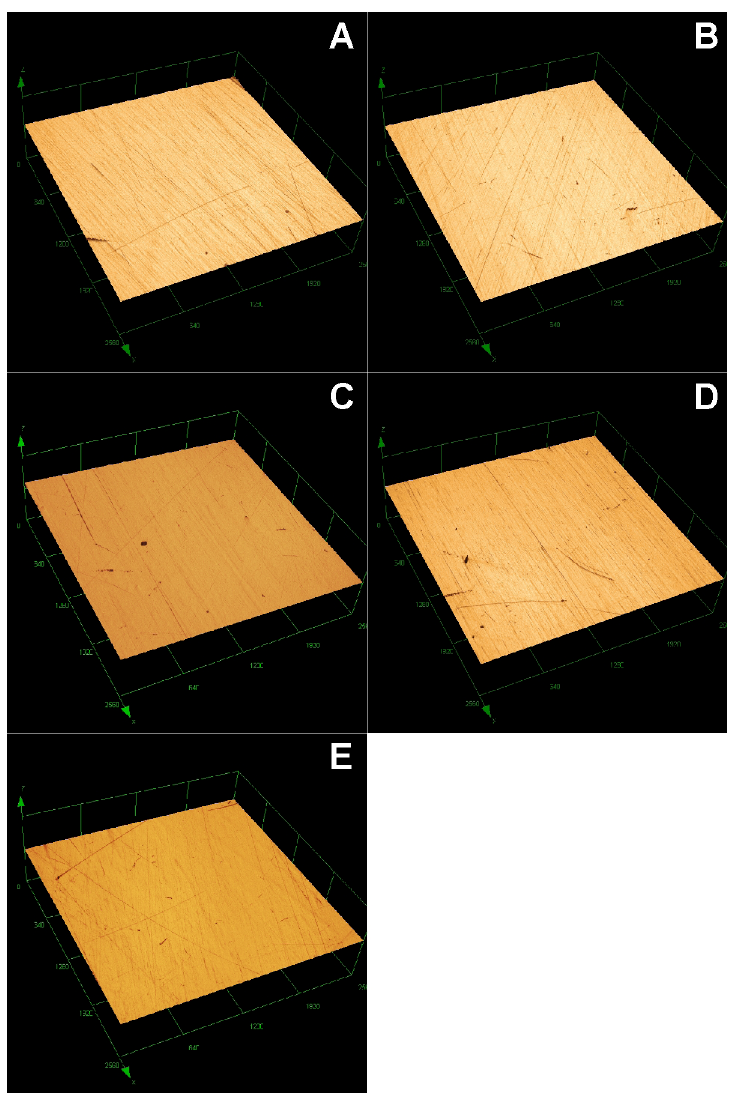
Figure 2- Representative 3D laser confocal microscopy images of specimens after immersion in different hygiene solutions. A) WI - Without Immersion; B) Control; C) RC – R. communis ; D) SH - Sodium Hypochlorite; E) EPC – Efferdent Power Clean. Magnification